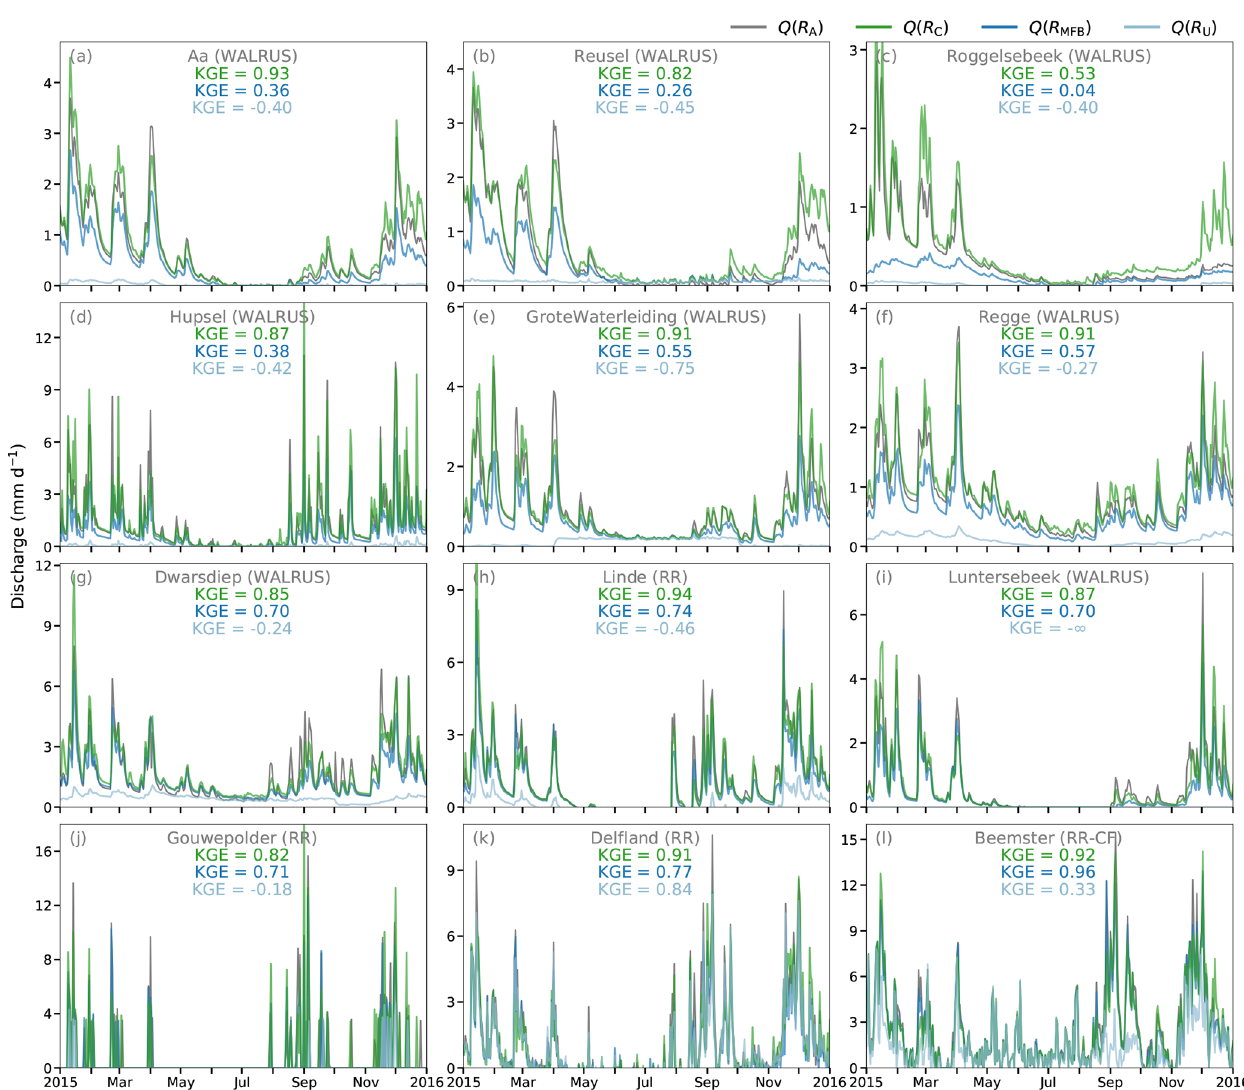
Figure 7. Differences in simulated discharges for the 12 basins (a–l) as a result of the differences between rainfall estimates. The models are run for the period 2009–2018 with the following rainfall products as input: the reference ( R A ; grey), the QPE corrected with the CAR- ROTS factors ( R C ; green), the MFB-adjusted QPE ( R MFB ; dark blue) and the unadjusted radar rainfall estimates ( R U ; light blue). Only the simulated discharges for 2015 are shown here for clarity; the KGE is based on all